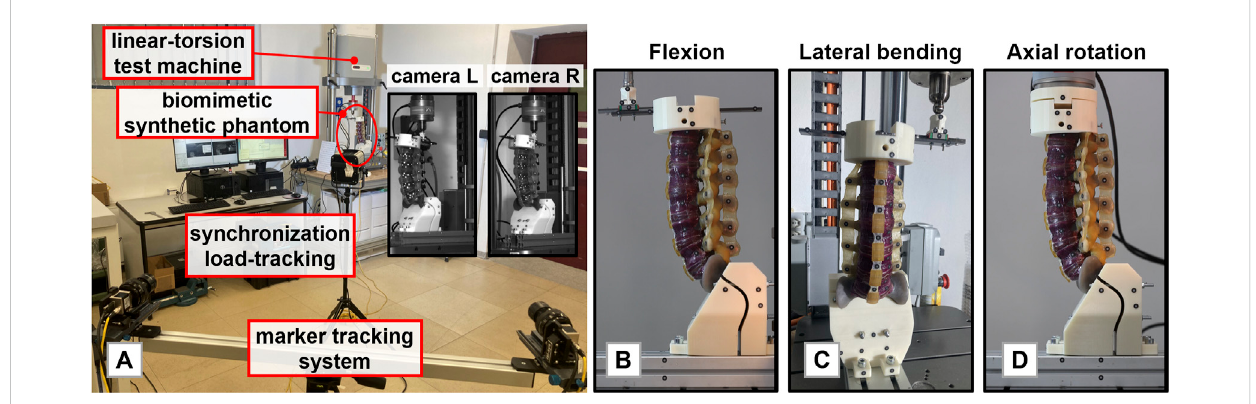
FIGURE 1 (A) : The experimental setup used to perform the tests. (B) : The synthetic phantom mounted in the loading apparatus for fl exion-extension case. (C) Thesyntheticphantommountedintheloadingapparatusforlateralbending.Flexion,extension,andlateralbendingwerereproducedbyalinearactuator and the combination of frictionless spherical and translational joints. (D) : The synthetic phantom mounted in the loading apparatus for axial rotation.